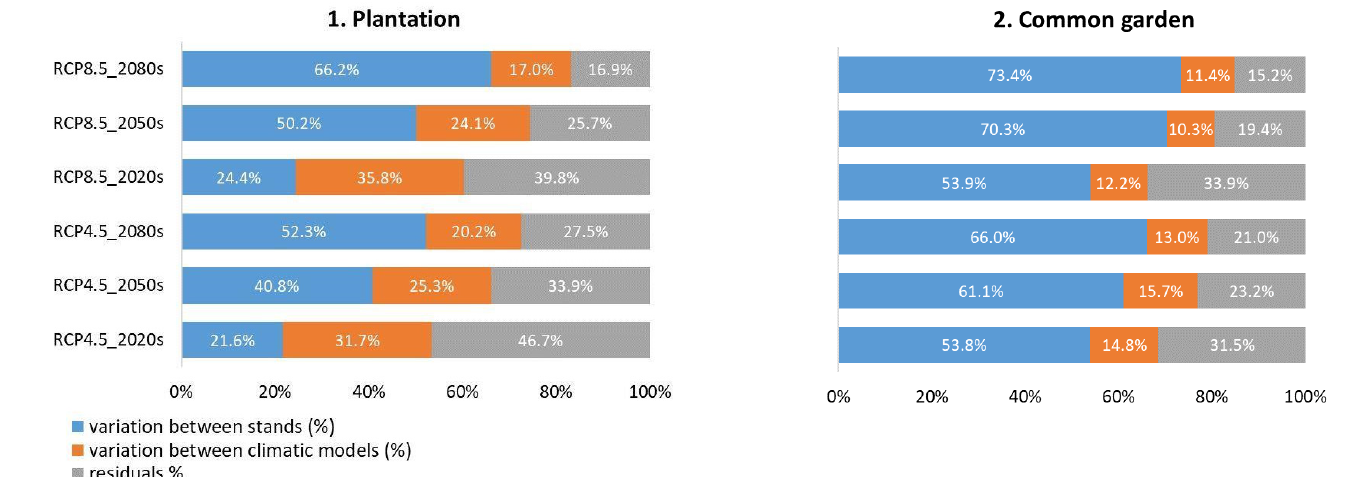
Figure 6. Shares of explained covariance among stands (trials), Global Climate Models (AOGCMs) and residuals for both the plantation stands and the common garden trials (13 plantation stands; 5 field trials) for two different emission scenarios (RCP4.5 and RCP8.5) and three projections periods. The projections of stand Ma and site 1013 were not included (see Section 2.5).